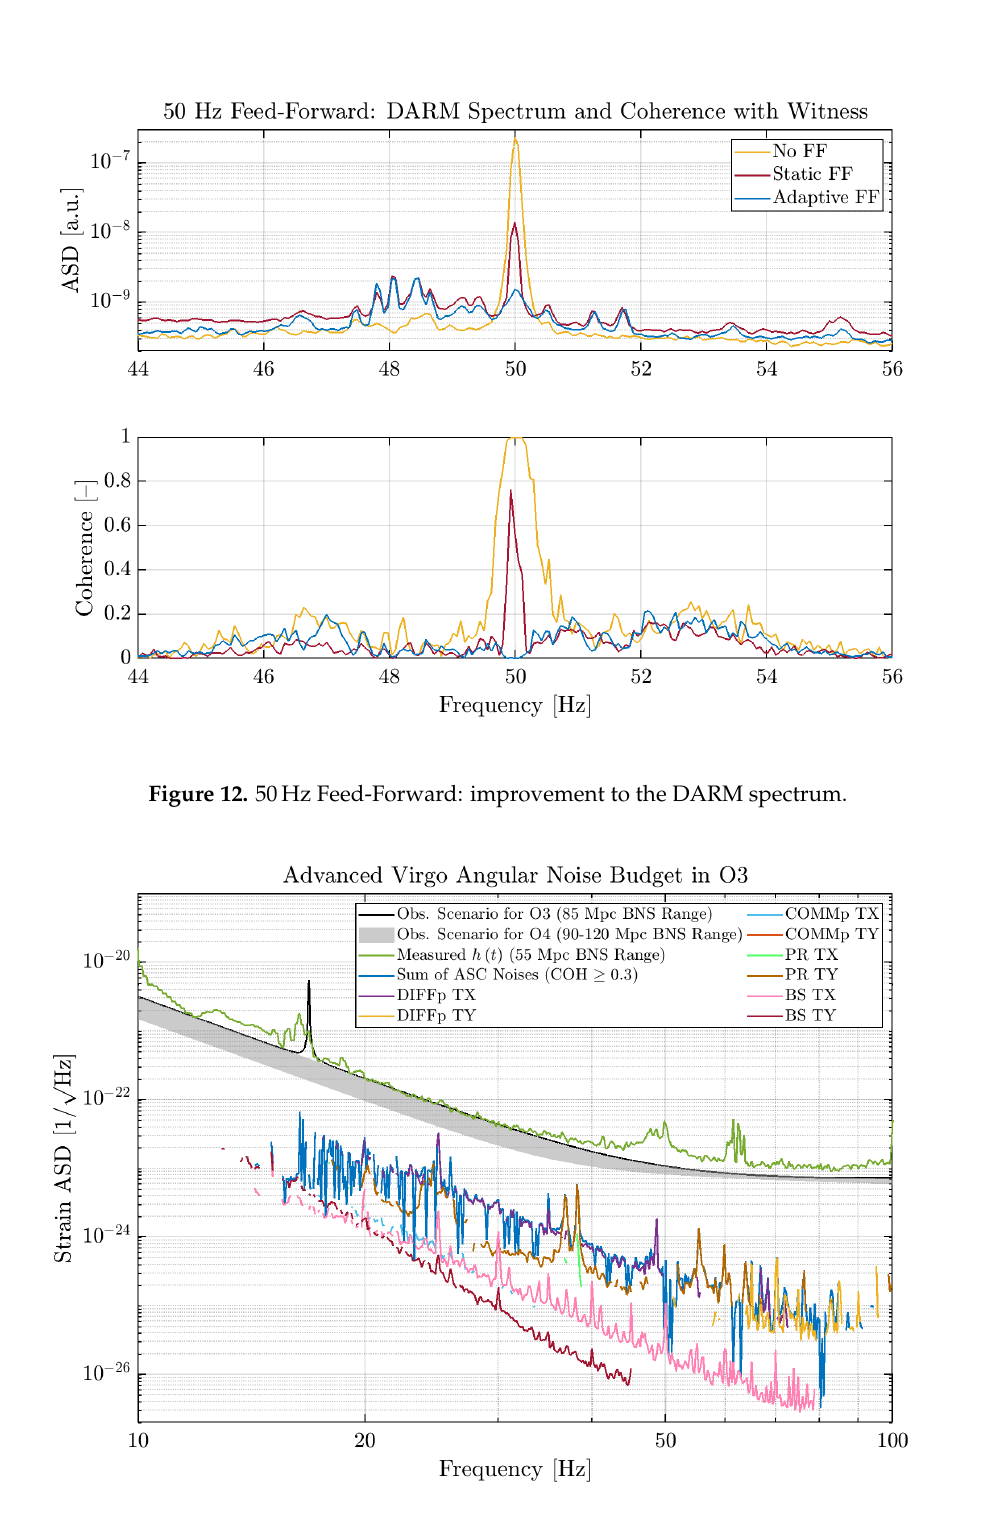
Figure 13. Angular Noise Budget for Advanced Virgo in O3. The Observing Scenario [19] target is set to 85Mpc BNS Range. No angular DOF is impacting the